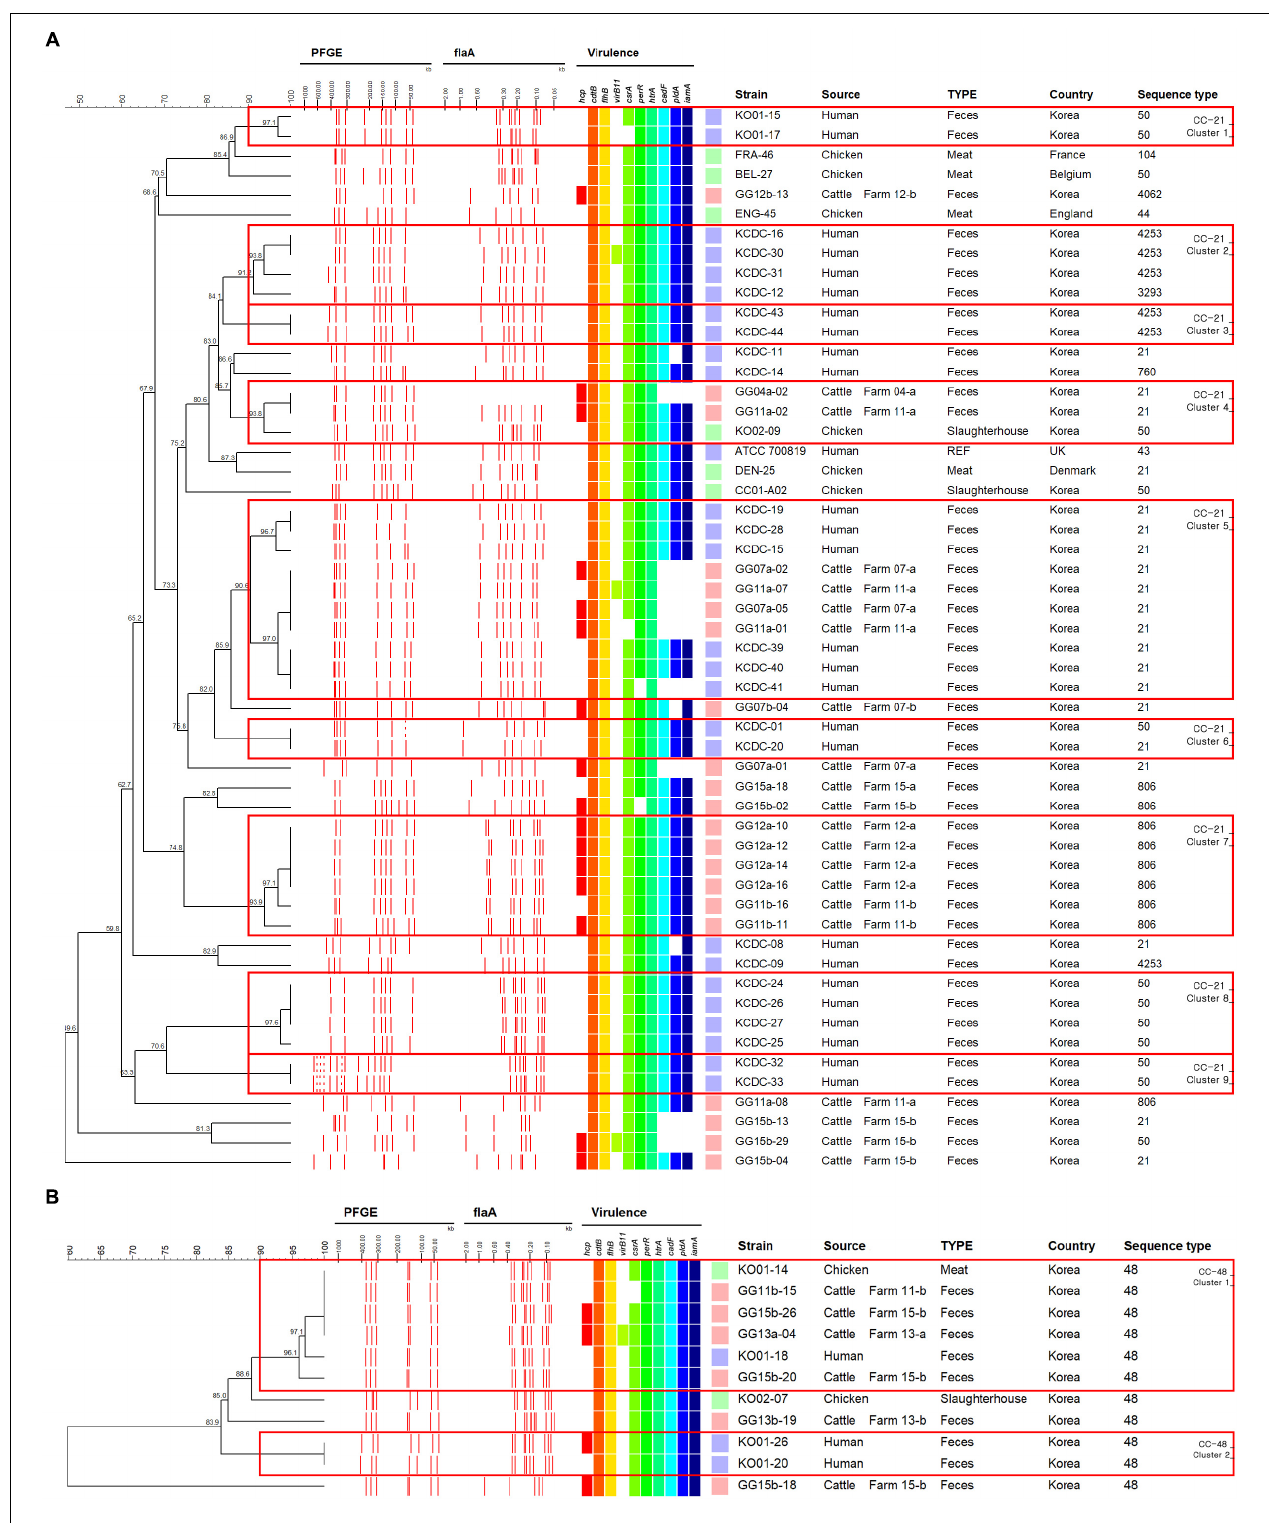
FIGURE 4 | UPGMA dendrogram based on PFGE and flaA -RFLP band pattern composite analysis for strains belonging to CC-21 and CC-48. (A) Strains belonging to CC-21. (B) Strains belonging to CC-48. Dendrograms were generated based on 2% optimization and 1.5% tolerance based on unweighted pair group method with arithmetic mean. Boxes indicate clusters created based on 90% similarity. The letter next to the farm number indicates the visit number (a – first visit and b – second visit).